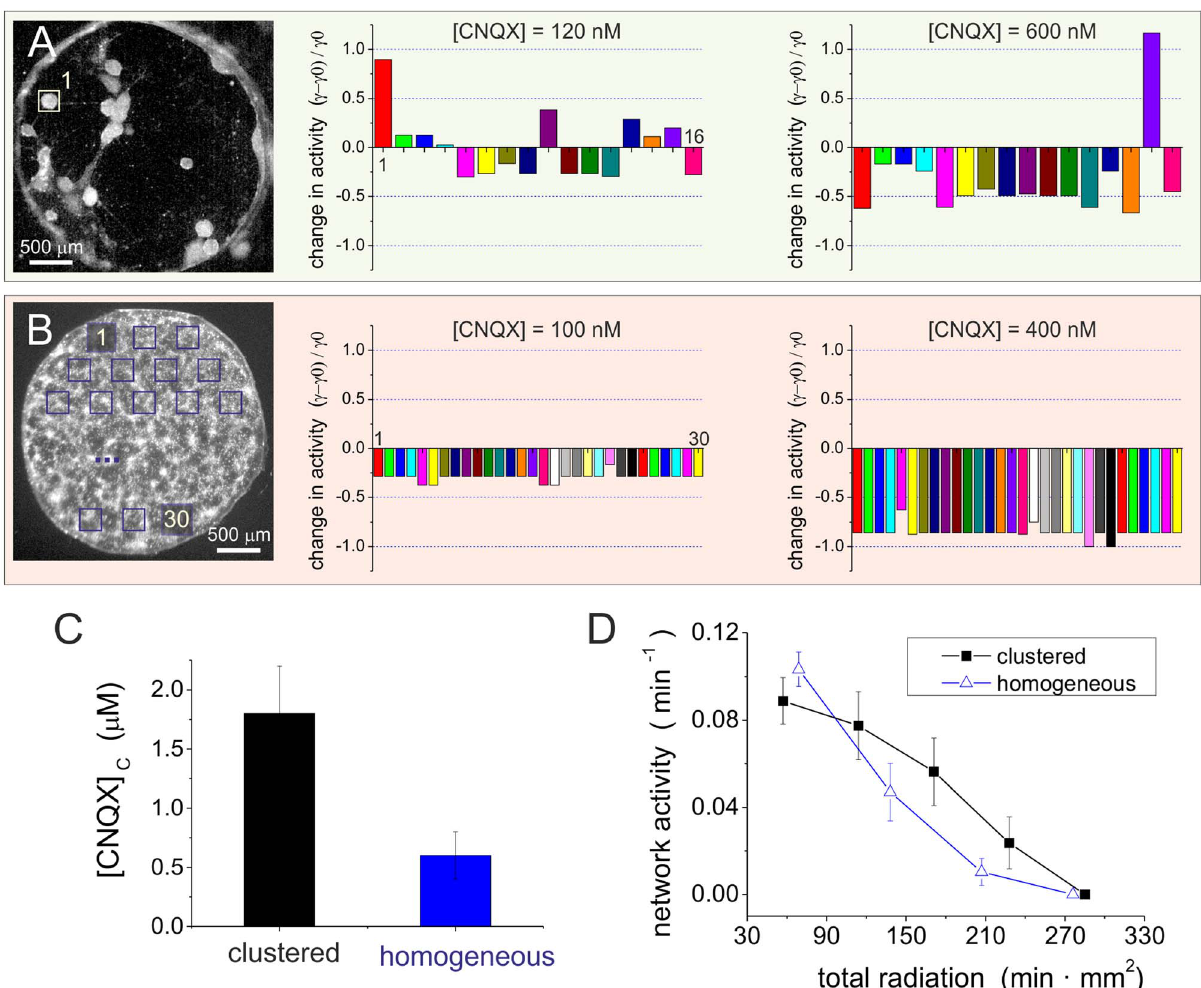
Figure 4. Network resilience to damage. A - B Examples of the degradation of neuronal activity in clustered and homogeneous cultures due to the gradual weakening of excitatory connectivity. Both culture types were investigated at the same day in vitro 14 and contained a similar density of neurons. The weakening of connections is achieved by gradually increasing the concentration of CNQX, an AMPA-glutamate receptor antagonist in excitatory neurons. Network response upon weakening is quantified through the relative change in activity ( c { c 0 ) = c 0 between a given CNQX application and the unperturbed state. Activity variations are indicated separately for each cluster, and shown according to the cluster labeling number. A Clustered cultures show a mixed response upon weakening, with some clusters increasing activity and others reducing it. Only for relatively high concentrations of CNQX ( * > 600nM ) the activity systematically decays up to the full silencing of the network. B In homogeneous cultures, activity is analyzed in 30 regions that cover in a regular manner the entire network. Activity decays almost equally in all regions. Relatively small drug concentrations of [CNQX] ^ 400nM practically suffice to fully stop activity. C Average critical concentration [CNQX] C at which spontaneous activity completed ceases, about 1 : 6 m M for clustered networks and 0 : 5 m M for homogeneous ones. Data is averaged over 4 network realizations of each type of culture. D Photo-damage experiments. Spontaneous activity is measured in cultures that are continuously exposed to strong fluorescence light, causing gradual neuronal degradation and ultimately the death of the entire network. The total radiation received by the neurons is calculated as the duration of the exposure times the area covered by the neurons in the culture ( 1 : 9mm 2 and 2 : 3mm 2 on average for clustered and homogeneous clusters, respectively). The spontaneous activity in homogeneous cultures decays at a much faster rate than in the clustered counterparts. Data is averaged over 6 network realization of each type. Error bars show standard deviation.